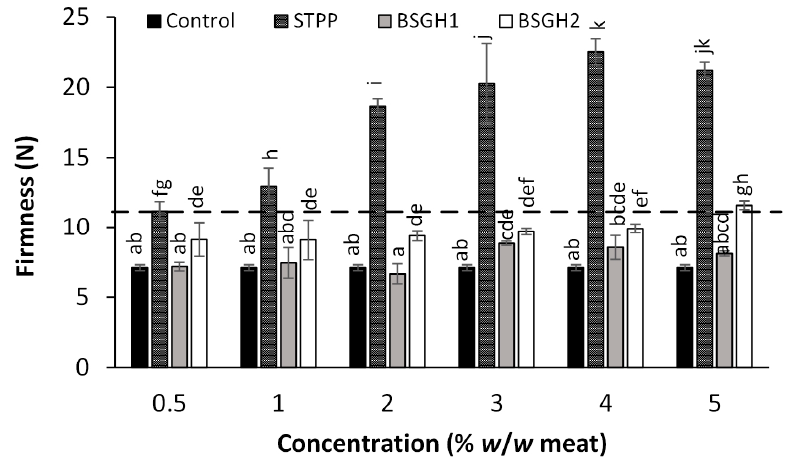
Figure 2. Effect of BSGH1, BSGH2, or STPP on the “firmness” (force in Newtons for 30% deformation) Figure 2. E ff ect of BSGH1, BSGH2, or STPP on the “ fi rmness” (force in Newtons for 30% defor- of thermally processed chicken meat. The values are presented as the mean ± standard deviation of mation) of thermally processed chicken meat. The values are presented as the mean ± standard de- three replicates. Different letters indicate significant differences ( p ≤ 0.05). The dashed line represents viation of three replicates. Di ff erent le tt ers indicate signi fi cant di ff erences ( p ≤ 0.05). The dashed line the firmness of STPP at the maximum concentration allowed in the industry (0.5% w / w meat). Figure 2. E ff ect of BSGH1, BSGH2, or STPP on the “ fi rmness” (force in Newtons for 30% defor- represents the fi rmness of STPP at the maximum concentration allowed in the industry (0.5% w / w mation) of thermally processed chicken meat. The values are presented as the mean ± standard de- In the case of STPP, this improvement was dependent on the concentration of the meat). viation of three replicates. Di ff erent le tt ers indicate signi fi cant di ff erences ( p ≤ 0.05). The dashed line ingredient; at concentrations over 3% ( w / w meat), no differences in firmness were observed represents the fi rmness of STPP at the maximum concentration allowed in the industry (0.5% w / w ( p > 0.05), which correlates with the WHC results obtained in our previous study meat).